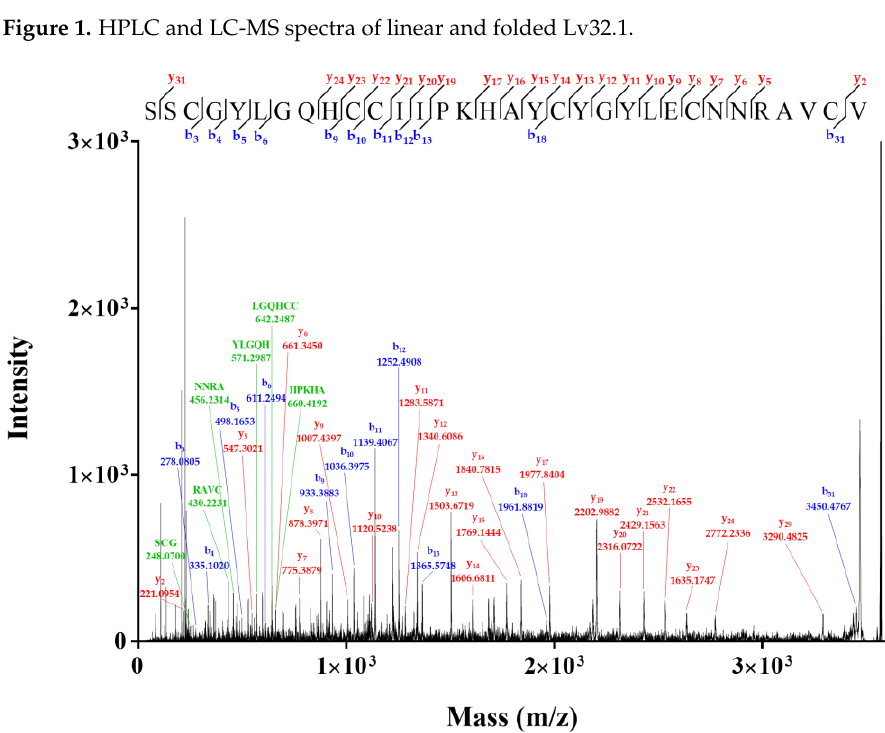
Figure 2. MALDI-TOF-MS/MS spectrum for sequencing of synthetic Lv32.1.